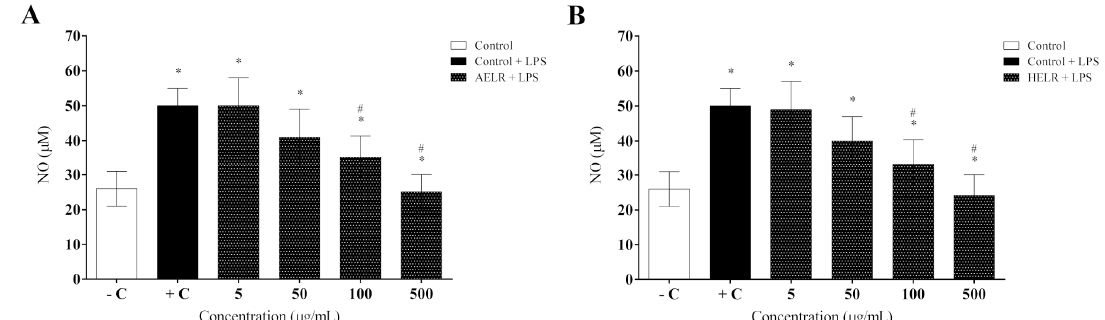
Figure 7. LPS-stimulated cytokine production in C57BL/6 mice. Effect of extracts on: ( A ) TNF- α secretion, ( B ). IL-1 β secretion and ( C ) IL-6 secretion. AELR ( L. rigida aqueous leaf extract). HELR ( L. rigida hydroethanolic leaf extract). − C (negative control: animals not induced with LPS). +C (positive control: animals induced with LPS and treated with PBS). Results represent mean cytokine levels (pg/mL) as well as standard deviations between animals in each group. Symbols indicate a statistical difference ( p < 0.05) by ANOVA, with Tukey post-test in the comparison between compounds. * p < 0.05 vs. the negative control group; ** p < 0.05 vs. the LPS-stimulated group; *** p < 0.05 between the extracts. n = 6.